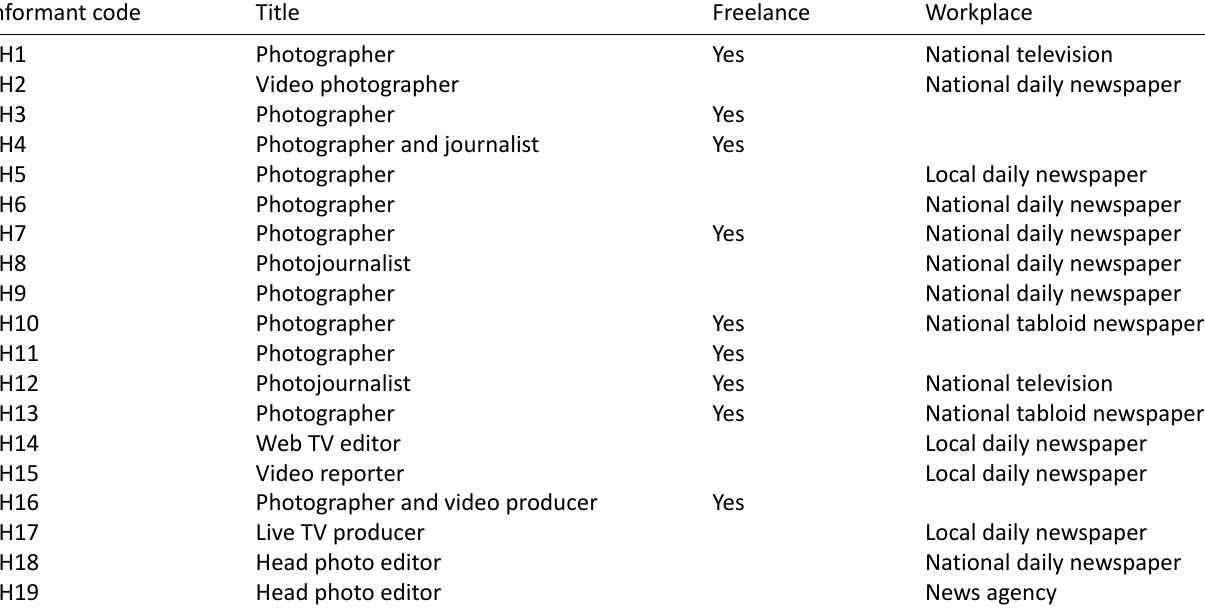
Table 1. List of photojournalists interviewed in the study. Informant